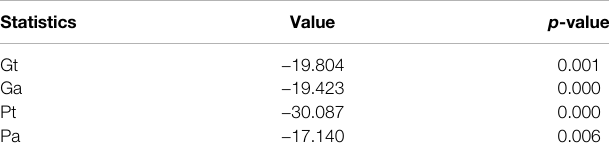
TABLE 3 | Cross-sectional dependence test results. TABLE 4 | Results of Westerlund co-integration.